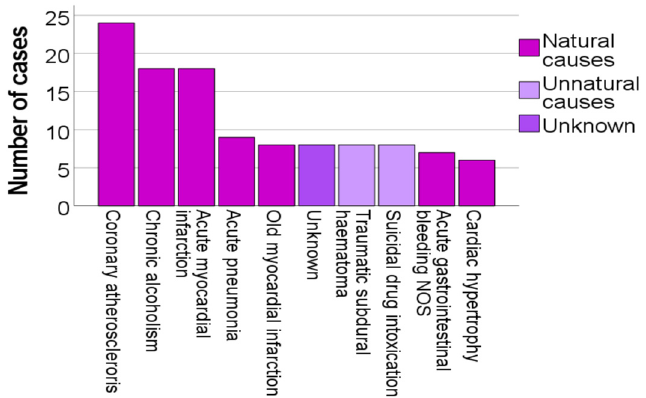
Figure 4. Ten most frequent non-acidotic causes of death when BHB ≥ 250 μ g/g.